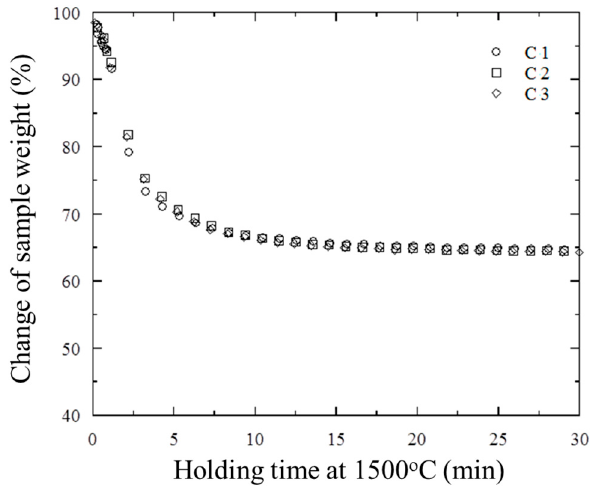
Figure 3. Typical changes of the weight of briquette samples over time during the TGR experiments.